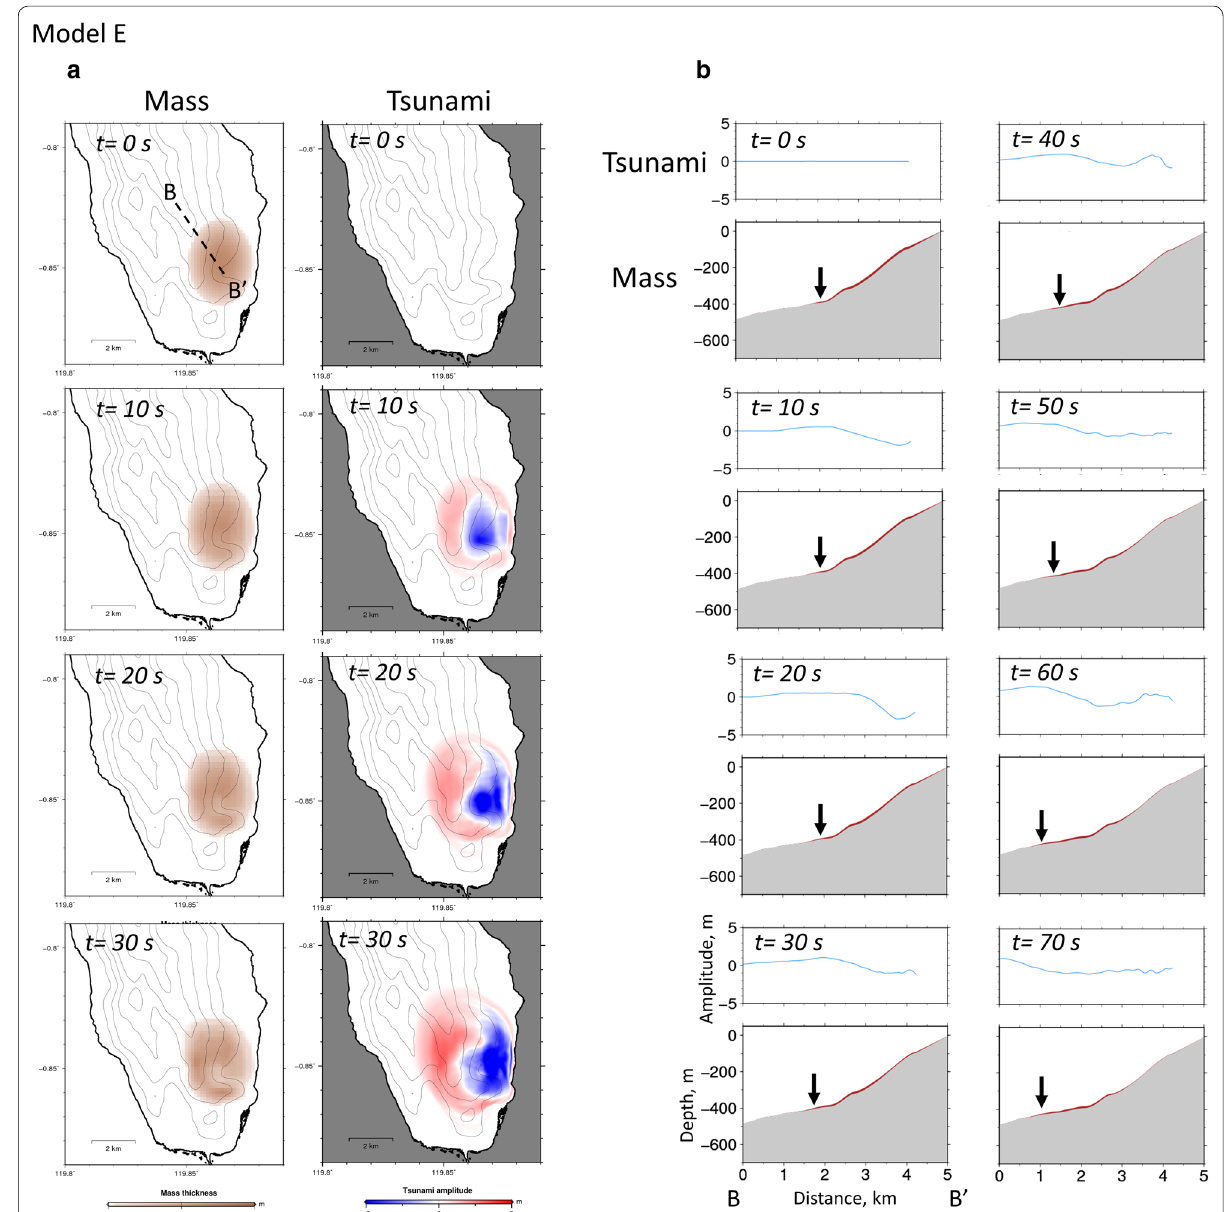
Fig. 8 Time-series of the calculated landslide mass motion and generated tsunami in model E. a Same as Fig. 6a for model E. b Cross-section along line B–B ′ in a . Same as Fig. 6b for model